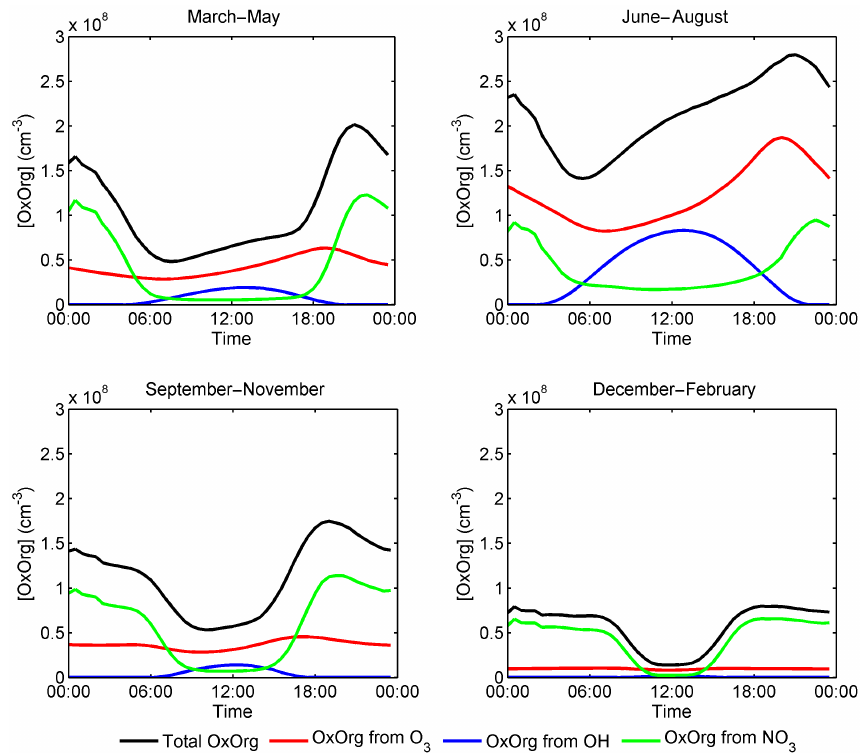
Figure 10. Diurnal variation of the proxy for the oxidation products of monoterpenes (OxOrg) during different seasons. The black line shows the total concentration of oxidation products, the red line the oxidation products of monoterpenes from the oxidation by O 3 , the blue line the oxidation products of monoterpenes from the oxidation by OH and the green line the oxidation products of monoterpenes from the oxidation by NO 3